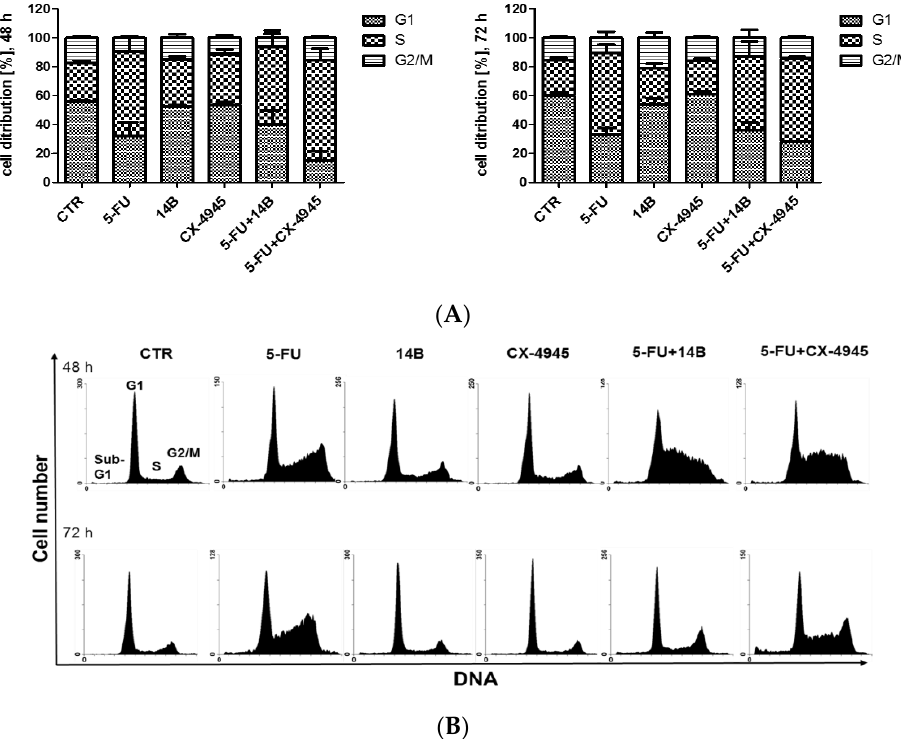
Figure 8. The effect of compound combinations on cell cycle progression in the MDA-MB-231 cell line. Cells were treated with 5-FU, 14B, or CX-4945, used separately or in combination for 48 h or 72 h, and then fixed and stained with PI. ( A ) Distribution of the cells in different phases of the cell cycle was determined by flow cytometry and analyzed with the MacCycle software to determine the percentage of cells in each phase of the cell cycle; ( B ) exemplary DNA histograms of the MDA-MB-231 cell line shown using the WinMDI 2.8 software.